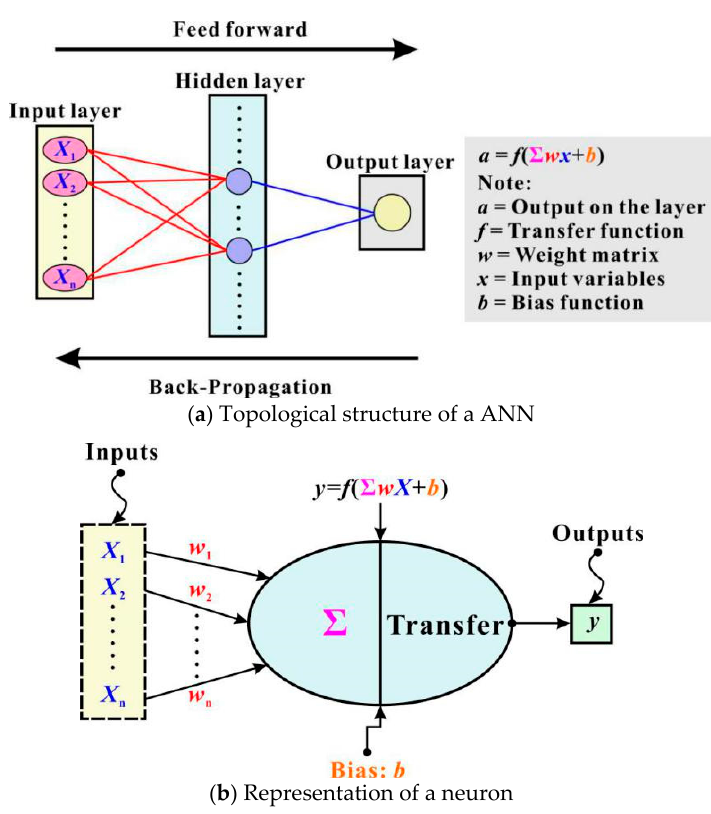
Figure 3. Schematic illustrations of artificial neural network (ANN) and neuron.